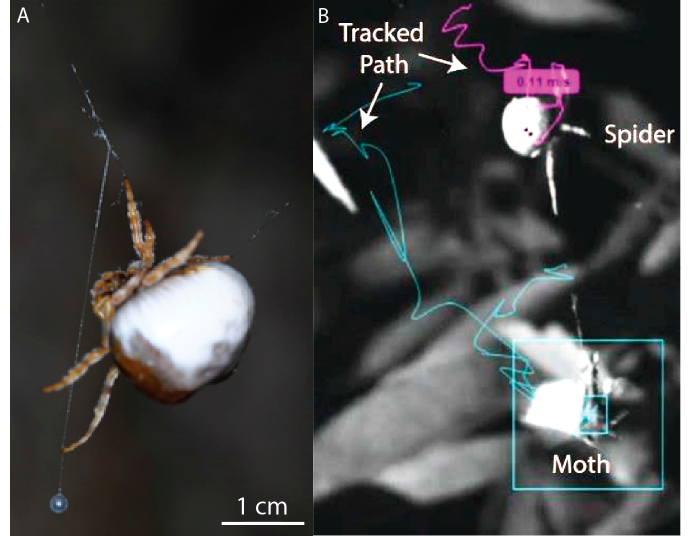
Figure 1. Nighttime, near-infrared image capture of spiders, their bolases, and the moths with which they interact. All images collected in the field. ( A ) Mastophora hutchinsoni dangling its bolas, with